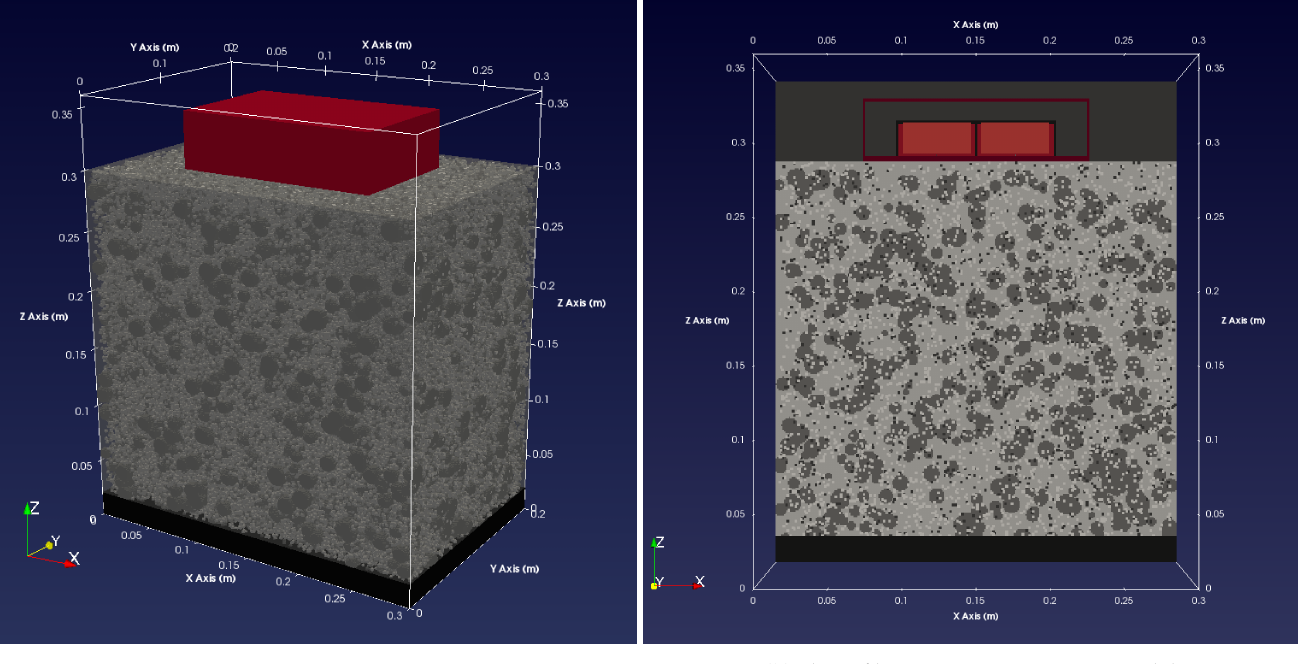
Figure 2. Heterogeneous concrete model is plotted using Paraview [68]. The model employs a 1.5 GHz centre frequency GSSI-like antenna structure on top of the concrete. A PEC plate is placed below the concrete model in order to obtain a perfect reflection. The geometry dimension of the models is 30 cm × 20 cm × 36 cm. ( a ) 3D view of the concrete model. ( b ) A slice of the 3D model which allows for a better understanding of the material distribution.